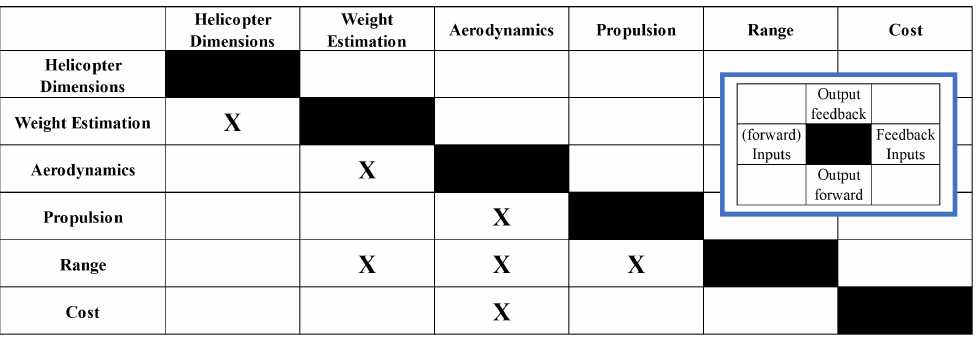
Table 3. The design structure matrix (DSM), indicating model inputs and outputs with “X” according to the legend highlighted in